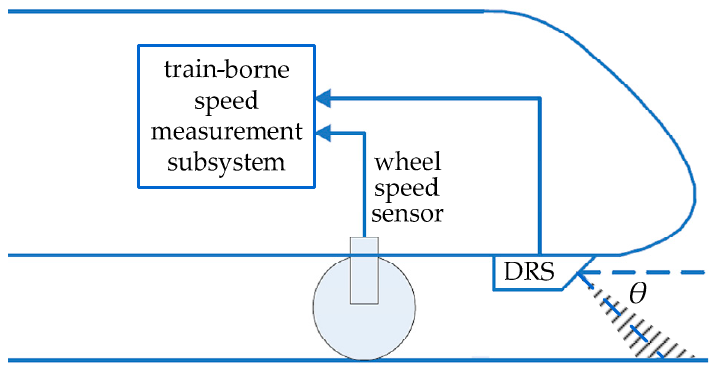
Figure 1. The installation schematic of train-borne DRS.